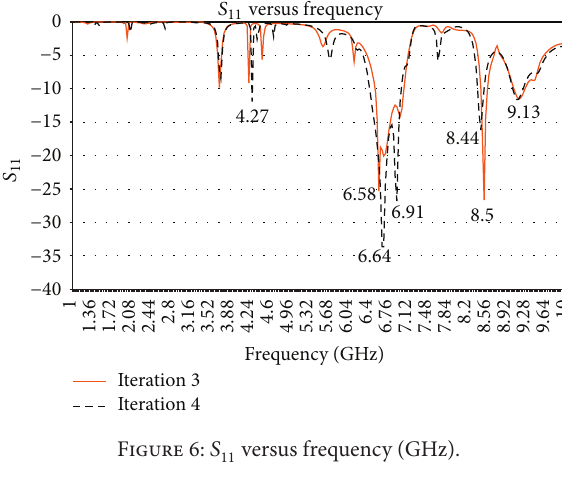
Figure 5: 𝑆 11 versus frequency (GHz).